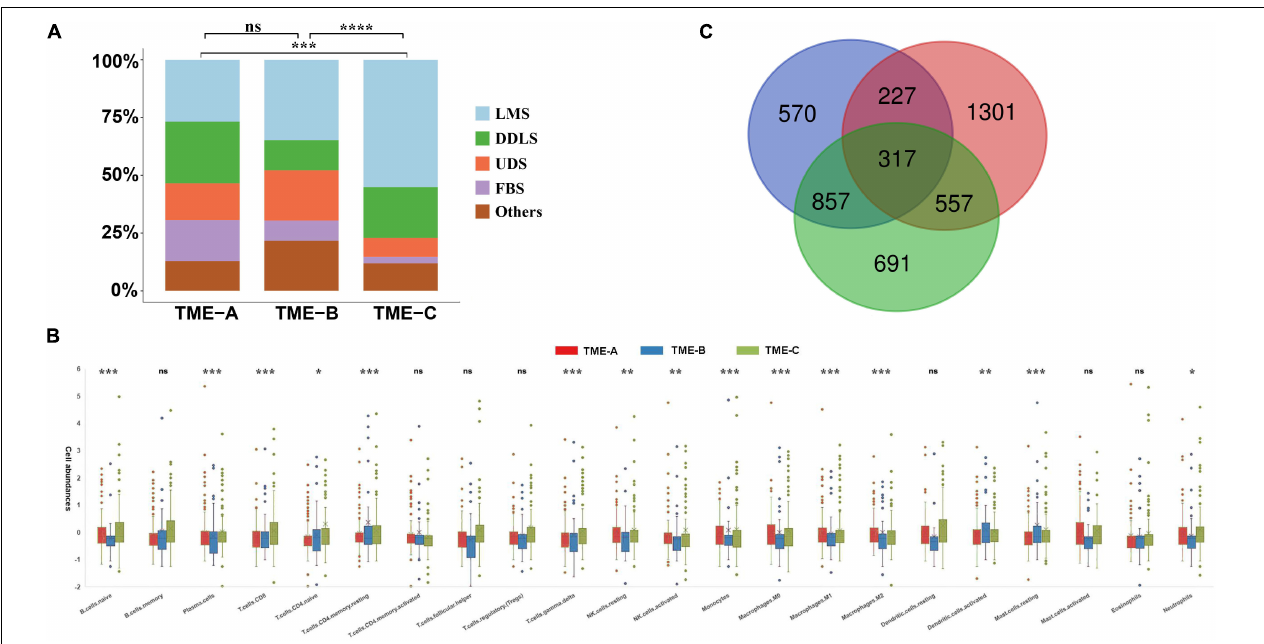
FIGURE 2 | Characteristics of three TME groups. (A) The distribution of tumor histological types in three TME groups. The Fisher’s test was applied to verify the difference in the distribution of sarcoma histological types in TME groups. The P value is labeled with asterisks in each grid (**** P < 0.0001, *** P < 0.001, ** P < 0.01, * P < 0.05, and ns no significance). LMS: Leiomyosarcoma; DDLS: Dedifferentiated liposarcoma; UDS: Undifferentiated sarcoma; and FBS: Fibromyxosarcoma. (B) The relative abundances of 22 immune cell types in three TME groups. Z-score transformed the original cell abundances. Two vertical lines on each box represent Whisker upper and lower limits. The fork represents the mean and the horizontal line in the box represents the median. The points outside the box indicate the outlier points. The Kruskal–Wallis test is performed on the three TME groups for each immune cell type, where P value is labeled with asterisks above each box (*** P < 0.001, ** P < 0.01, * P < 0.05, and ns: no significance). (C) The Venn diagram of the overlapping DEGs between three